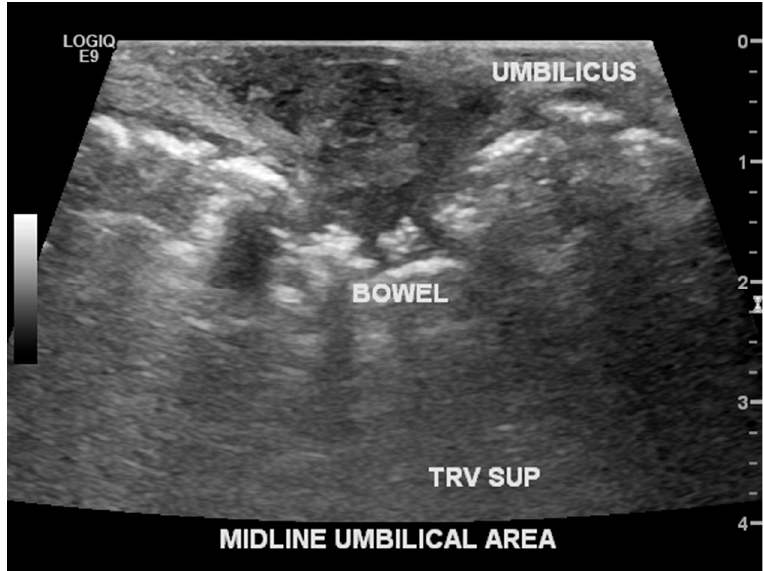
Figure 5. Abdominal ultrasound revealing intestine in the herniated part of umbilicus-omphalocele minor.